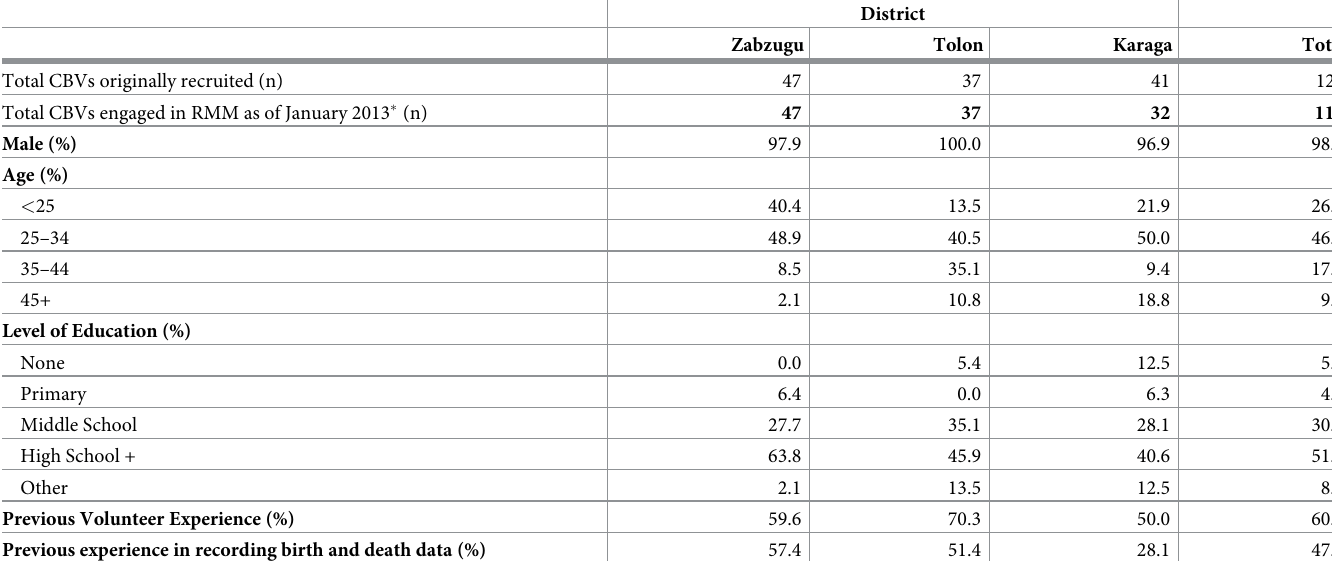
Table 1. Distribution of CBV characteristics by district.